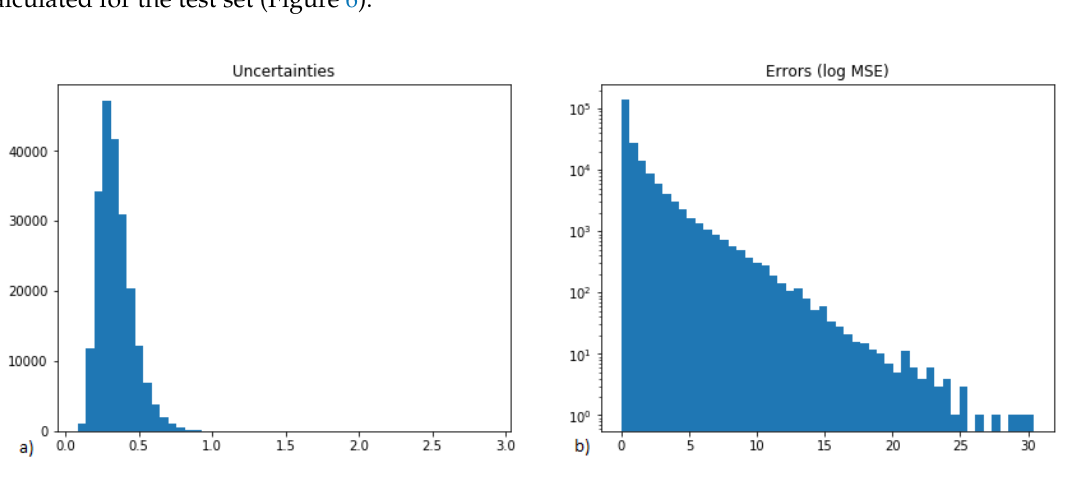
Figure 6. Analy sis of uncertainty and MSE of activity prediction (calculated for all targets considered). ( a ) uncertainty ; ( b ) prediction error expressed as log(MSE) .